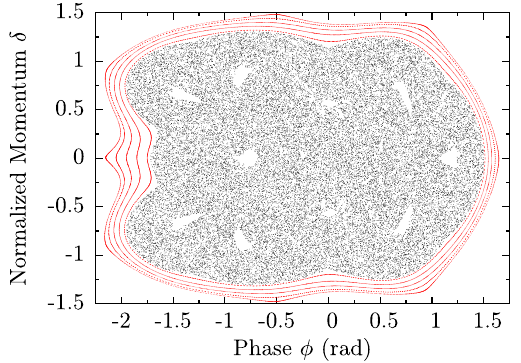
FIG. 18. Black: Poincaré surface of section of a small Gaussian bunch of rms length σ ϕ ¼ 1 × 10 − 3 rad and momentum spread σ ¼ 1 × 10 − 3 initially at the phase-space center at the last δ modulation periods of 1.5 million revolutions where a ¼ 45 °. The red points depict single-particle tracking of and Δ ϕ o test particles placed initially near the edge of the phase-space